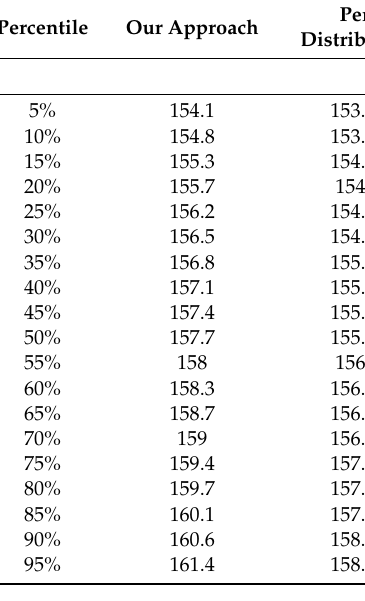
Table 9. Results’ percentiles for each method of the present